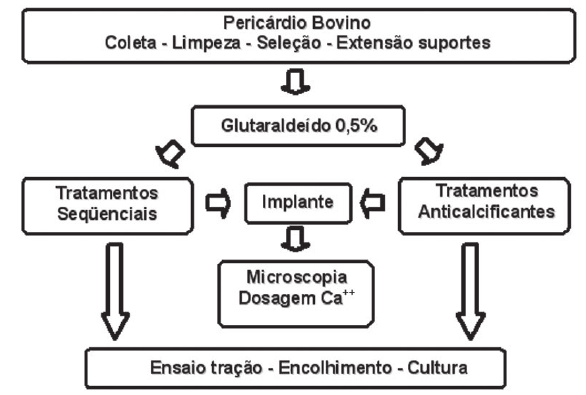
Fig. 1 - Fluxograma da metodologia